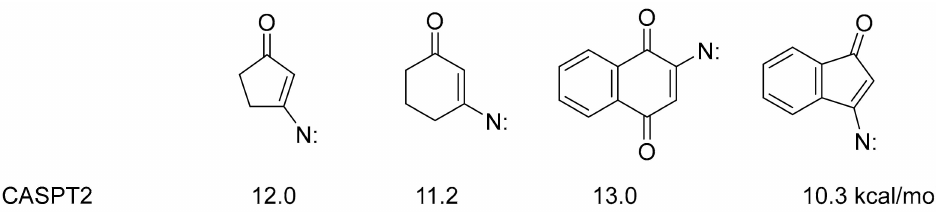
Scheme 7. Photoreactivity of isoxazoles in cryogenic matrices.